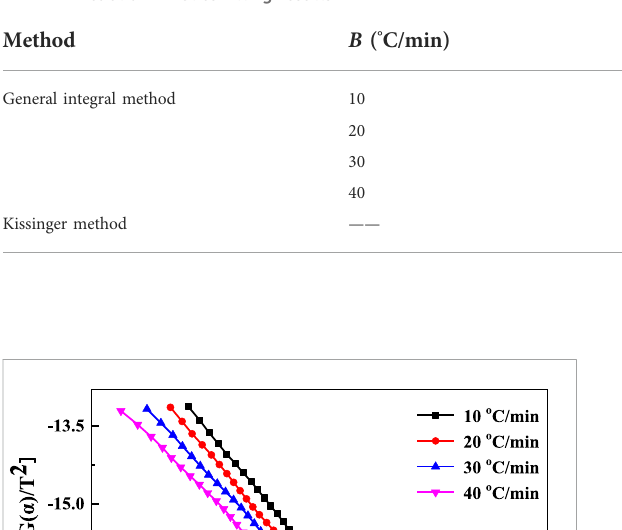
TABLE 4 Reaction kinetics fi tting results.